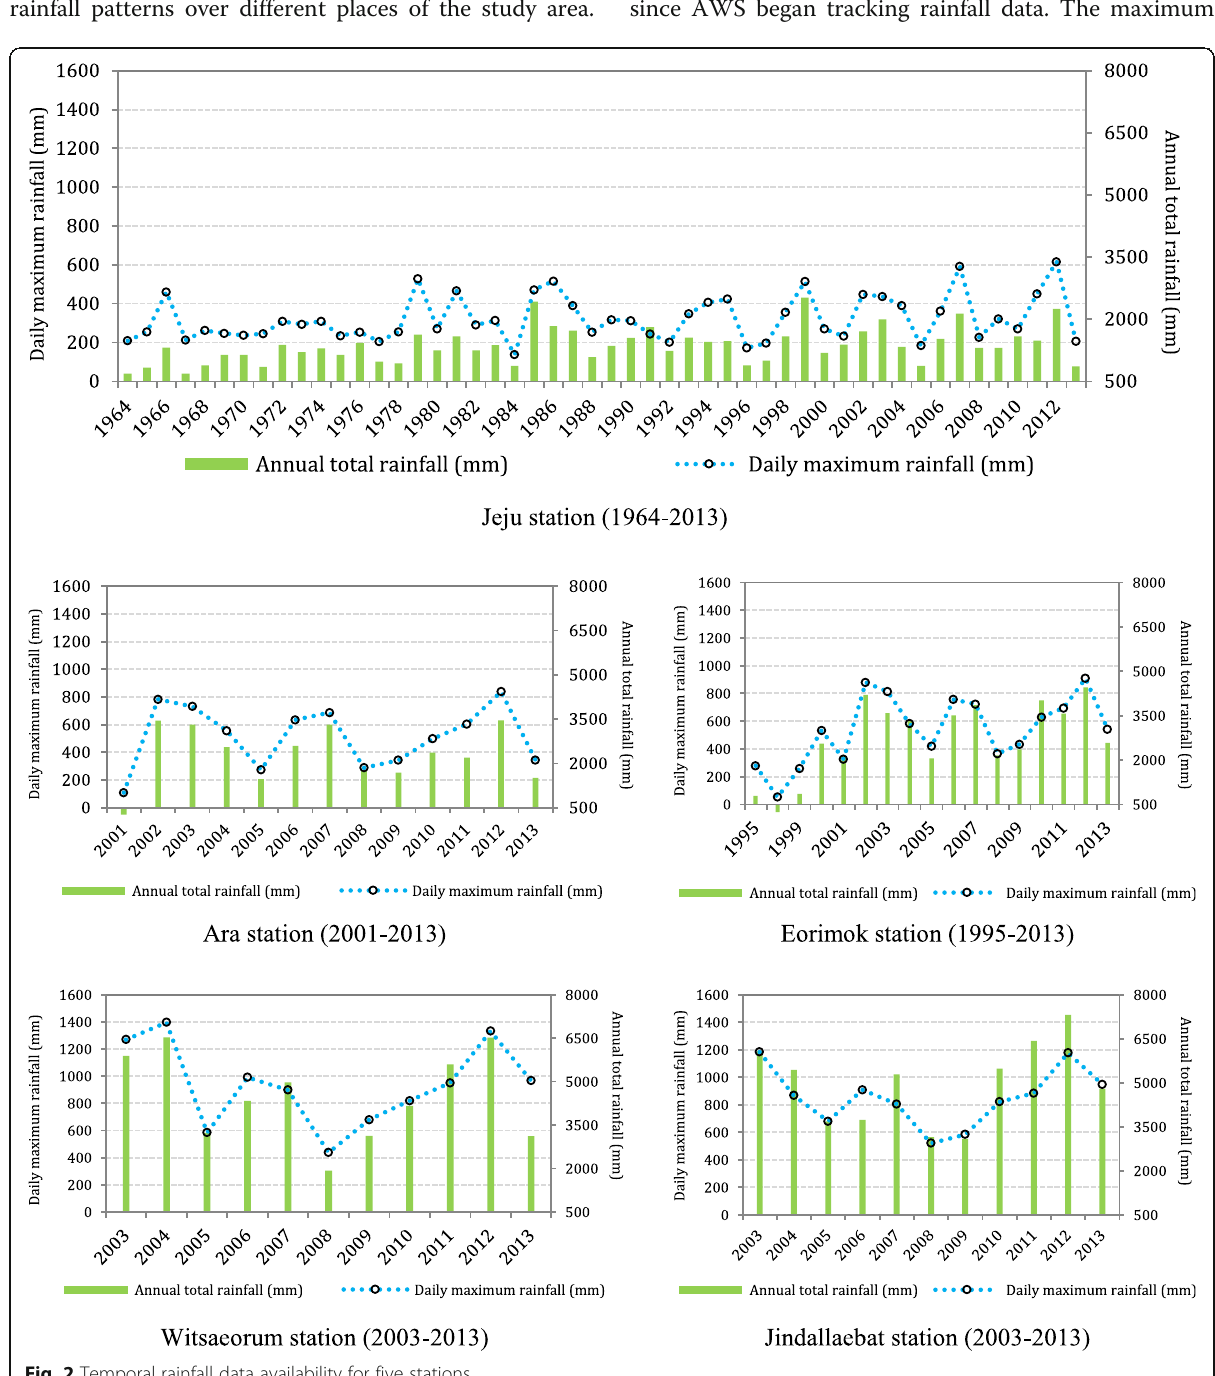
Fig. 2 Temporal rainfall data availability for five